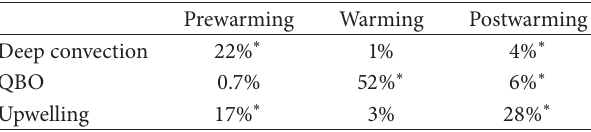
Table 2: Explained variances of deep convection, the QBO, and upwelling associated with the BDC during three periods in the regression model. Prewarming Warming Postwarming Deep convection 22 % ∗ 1% 4 % ∗ QBO 0.7% 52 % ∗ 6 % ∗ Upwelling 17 % ∗ 3% 28 % ∗